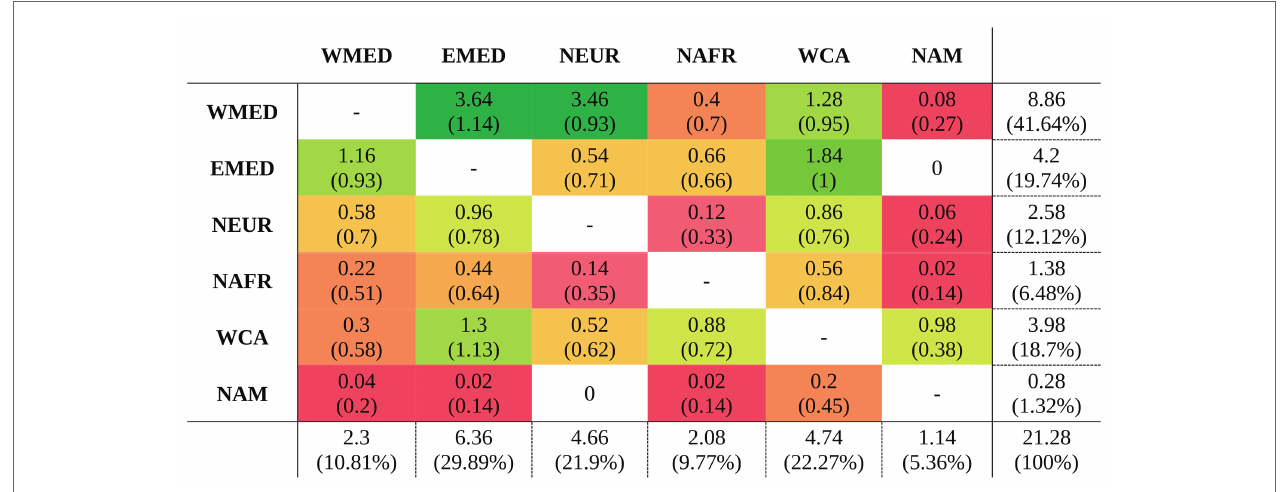
FIGURE 3 | Average number of dispersals and standard deviation (in parenthesis) after 50 BSMs obtained from BioGeoBEARS (Matzke, 2013) under the constrained DEC model in Centaurium . Source and sink areas are indicated in the y and x axes respectively, codified as follows: WMED for western Mediterranean; EMED, eastern Mediterranean; NEUR, northern Europe; NAFR, northern Africa; WCA, west and central Asia; and NAM for North America. The frequency of each event is also indicated by the cell color (green colors for more frequent events, and warmer colors for infrequent or null events). The last row and column summarize the dispersal events or destination of each area, respectively, indicating also the percentage of all events.